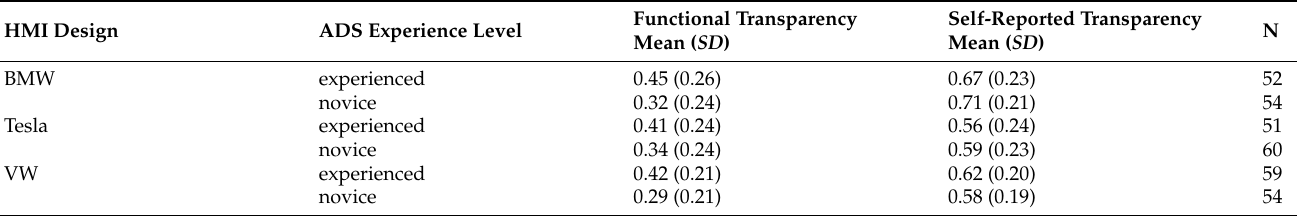
Table 2. Mean and standard deviation (SD) of measured FT and self-reported transparency with different HMI designs and ADS experience levels.